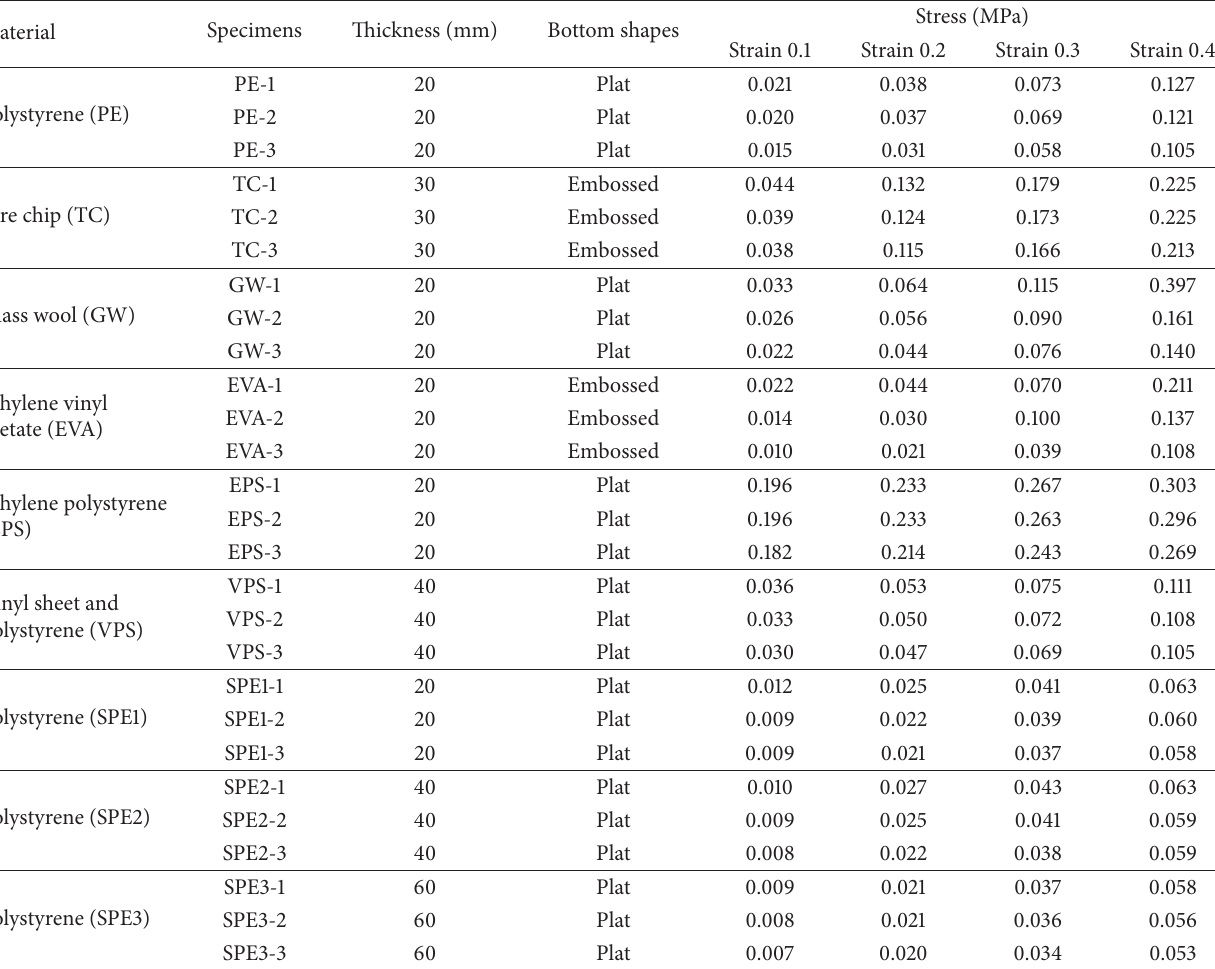
Table 1: Specification of resilient material specimens and test results.